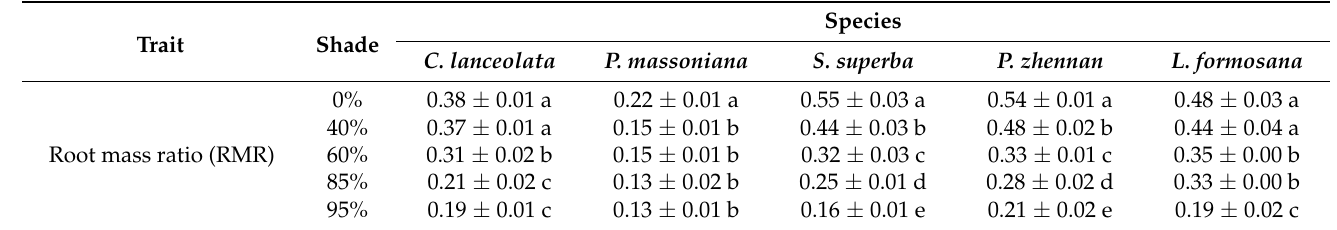
Table 3. Seedling biomass allocation characteristics of five tree species under different shade treatments.